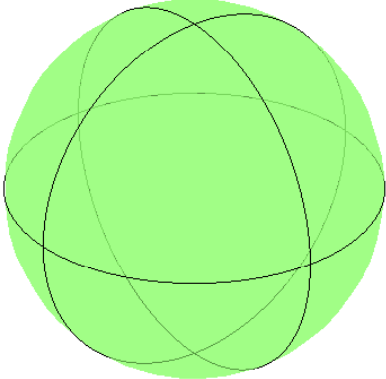
Figure 1. The eight spherical zones obtained as intersections of the coordinate planes with the ball B 3